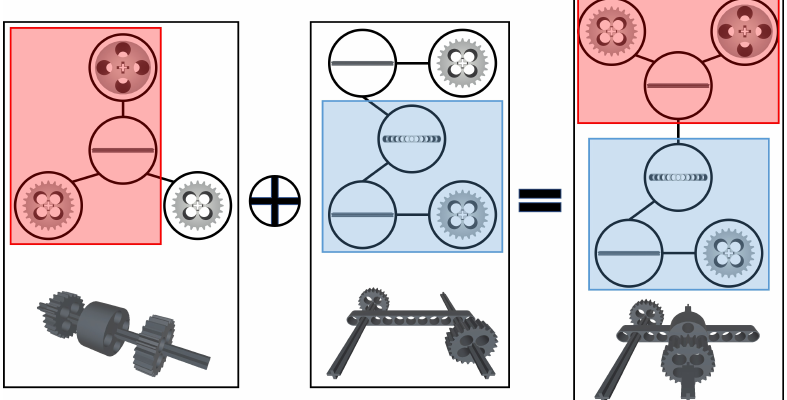
Figure 7. Crossover algorithm. Given two existing mechanical assemblies ( left ), two subgraphs (red and blue areas) are obtained from their associated graphs and then recombined to produce a new mechanical assembly ( right